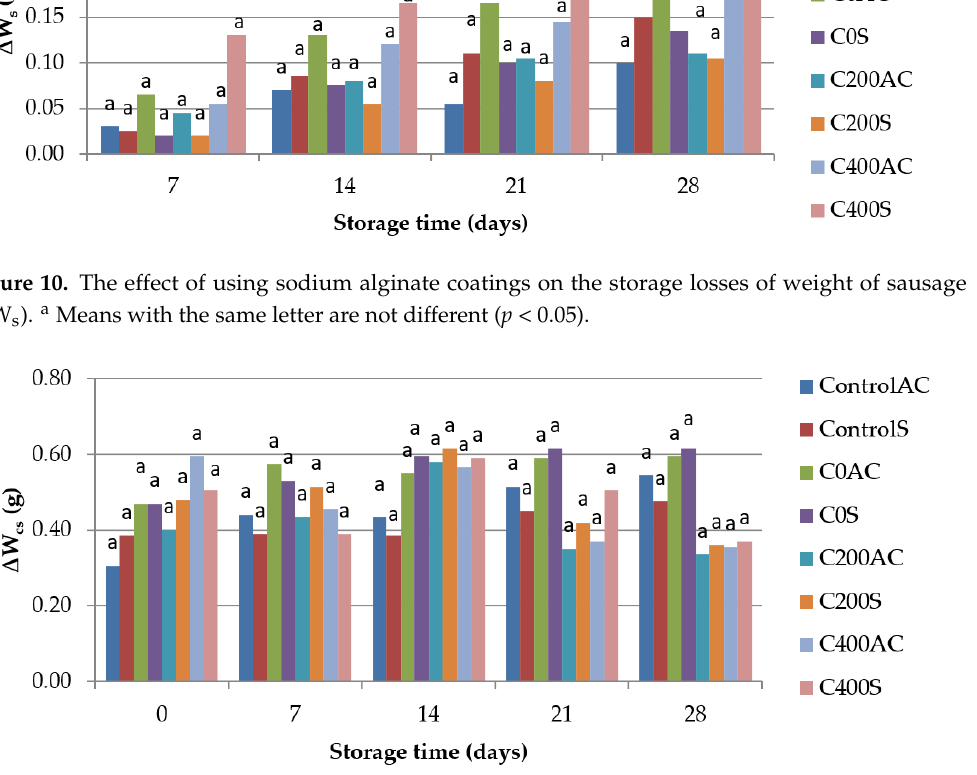
Figure 11. The effect of using sodium alginate coatings on the cooking losses of weight of sausages (∆ W cs ). a Means with the same letter are not different ( p < 0.05).